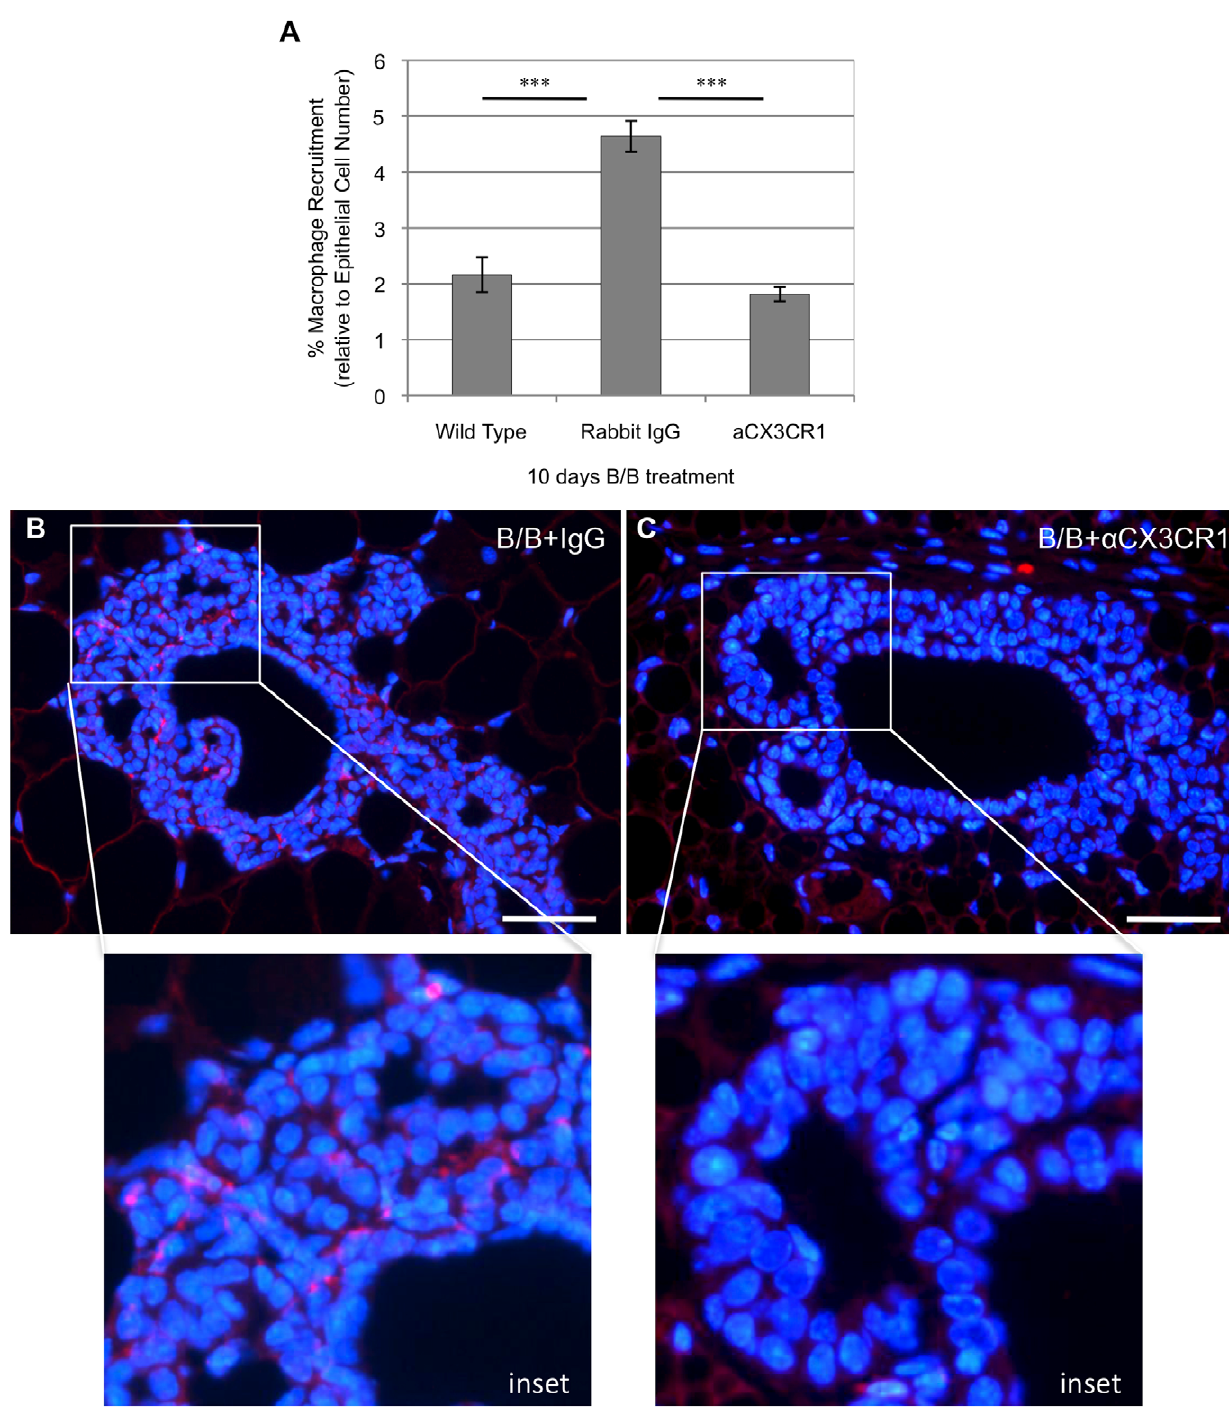
Figure 5. iFGFR1 activation invivo promotes recruitment of CX3CR1-positive macrophages. MMTV-iFGFR1 transgenic mice were treated with B/B in order to analyze the population of macrophages that are recruited to the mammary epithelium during early stages of iFGFR1-induced mammary tumorigenesis. A) MMTV-iFGFR1 mice treated with B/B demonstrated an increase in macrophage recruitment after 10 days as indicated by an increased in the number of F4/80 positive cells. MMTV-iFGFR1 mice treated with anti-CX3CR1 in conjunction with B/B demonstrated a reduction in macrophage recruitment at 10 days indicating that iFGFR1 activation is responsible for recruiting a subset of macrophages that express CX3CR1. ***p , 0.0001. Error bars represent SEM. B) Representative image of macrophages associated with budding epithelial structures in mammary glands from mice treated with control IgG antibody. C) Representative image of macrophages associated with budding epithelial structures in mammary glands from mice treated with anti-CX3CR1. Red=F4/80 staining, blue=DAPI. Scale bars represent 50 m M. Results in each figure panel are representative of a minimum of three different mice for each treatment group and genotype.